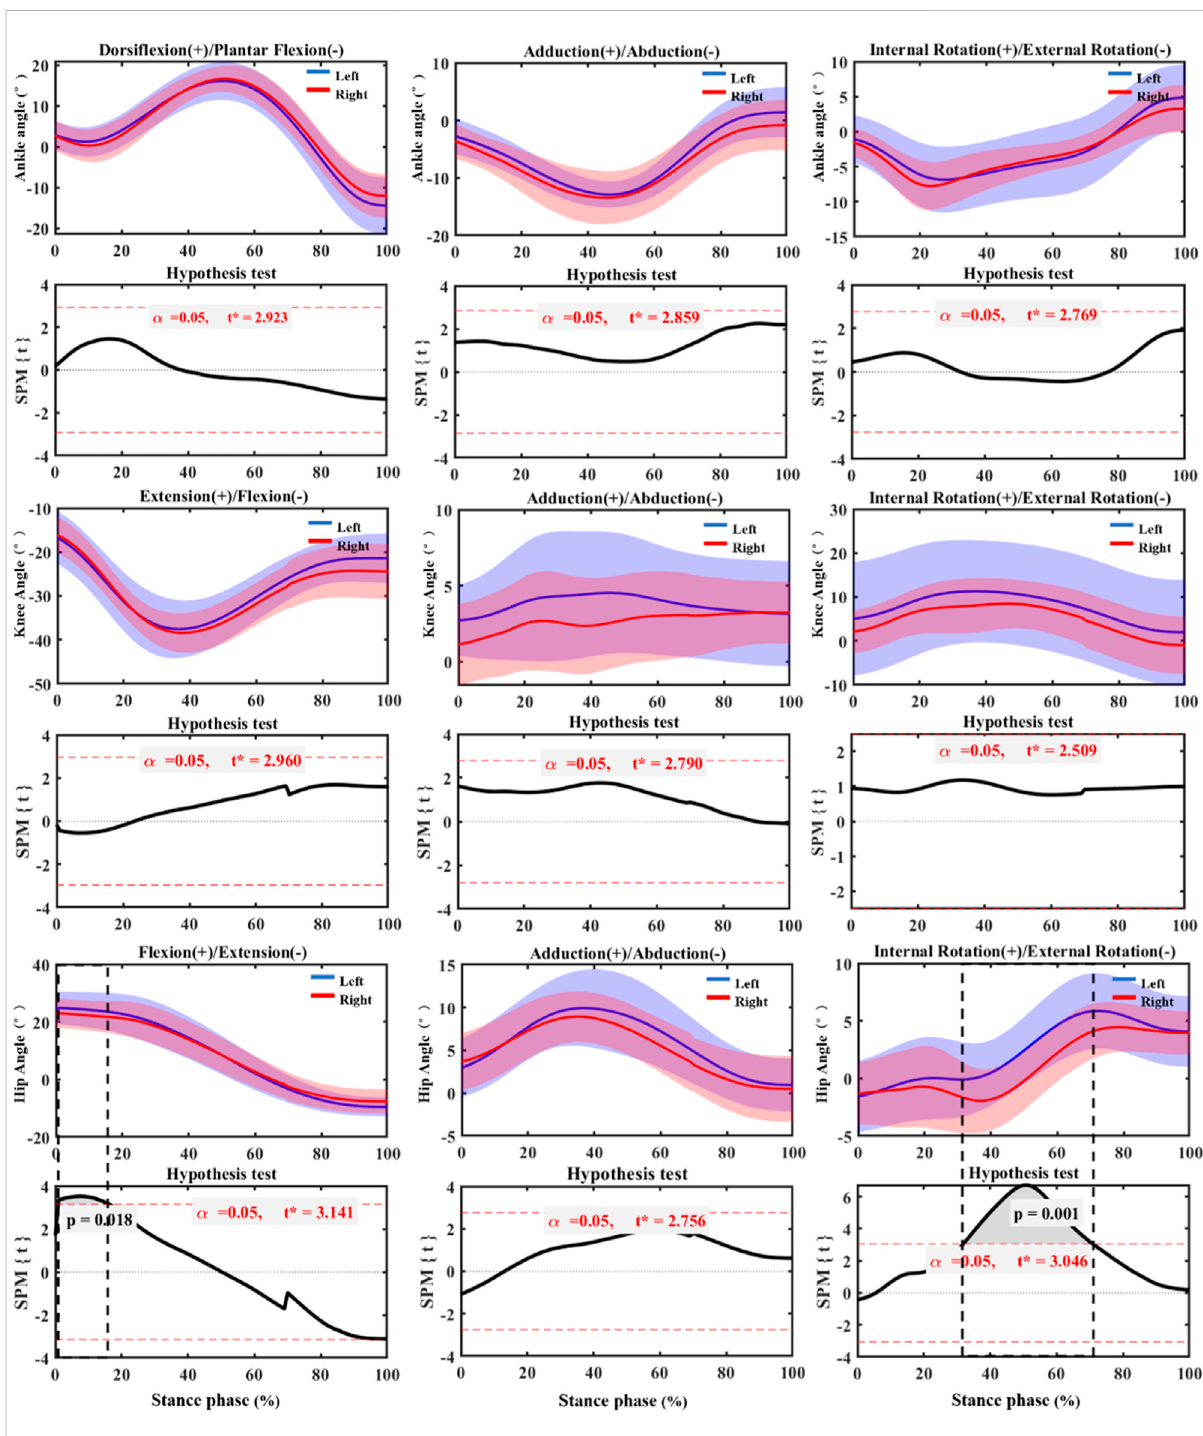
FIGURE 3 SPM_1dtestofjointanglechangesofbilaterallowerextremitiesbeforefatigueduringstancephase.Left:Leftlowerlimb(non-dominant).Right: Right (dominant) lower